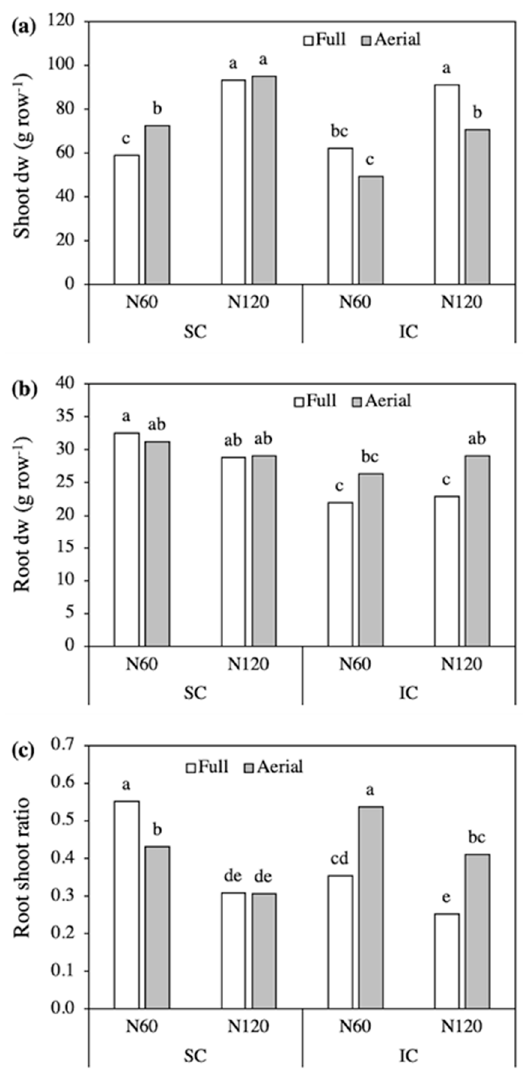
Figure 5. Shoot ( a ) and root ( b ) biomass and root:shoot ratio ( c ) of triticale, as affected by the Crop system × N level × Row contact interaction SC, sole crop; IC, intercrop. Values are means three replicates. In each figure, bars with different letters indicate that the corresponding means are significantly different at P < 0.05, Tukey’s test.